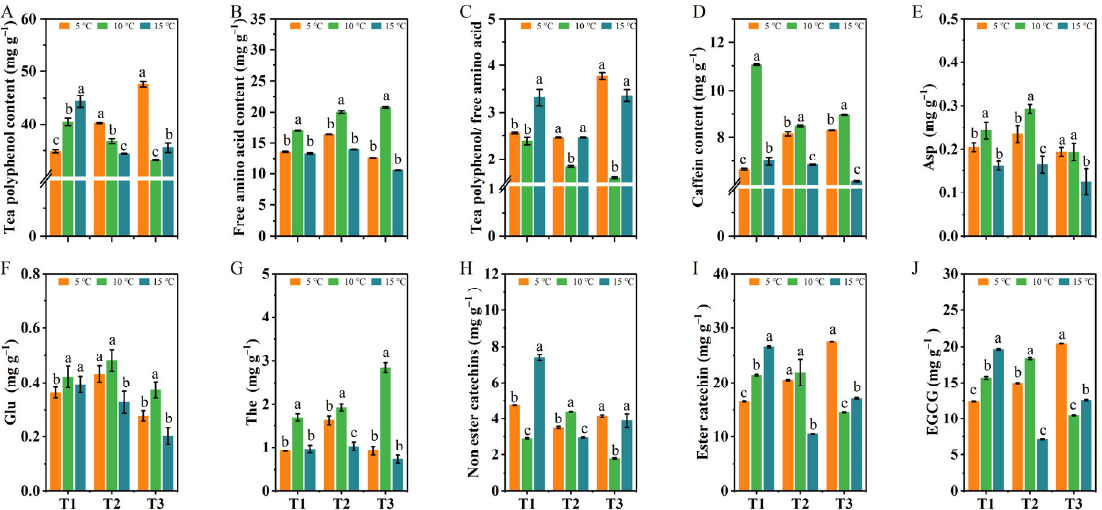
Figure 3. The effects of different DIFs on the contents of biochemical substances, amino acid components, and catechin components. ( A ) Tea polyphenols; ( B ) Free amino acids; ( C ) The ratio of tea polyphenols and free amino acids; ( D ) Caffeine; ( E ) Aspartic acid; ( F ) Glutamate; ( G ) Theanine; ( H ) Non ‐ ester catechin; ( I ) Ester catechin; ( J ) Epigallocatechin gallate. Different letters indicate treatments that are significantly different at p < 0.05 ( n = 3).